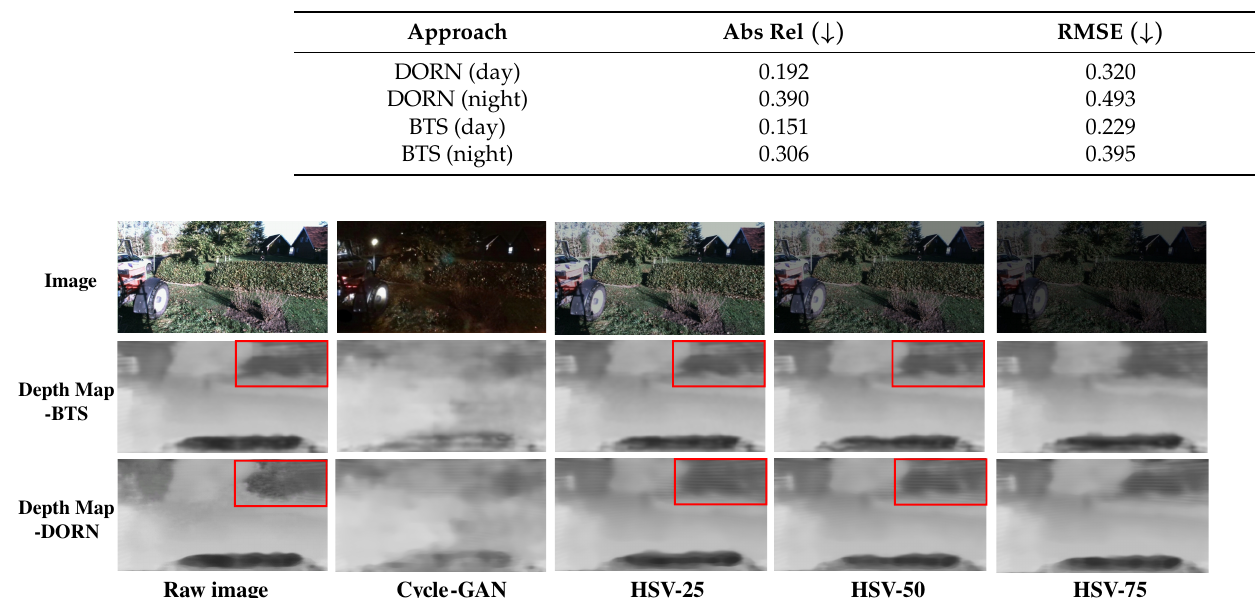
Table 2. Results of monocular depth estimation.